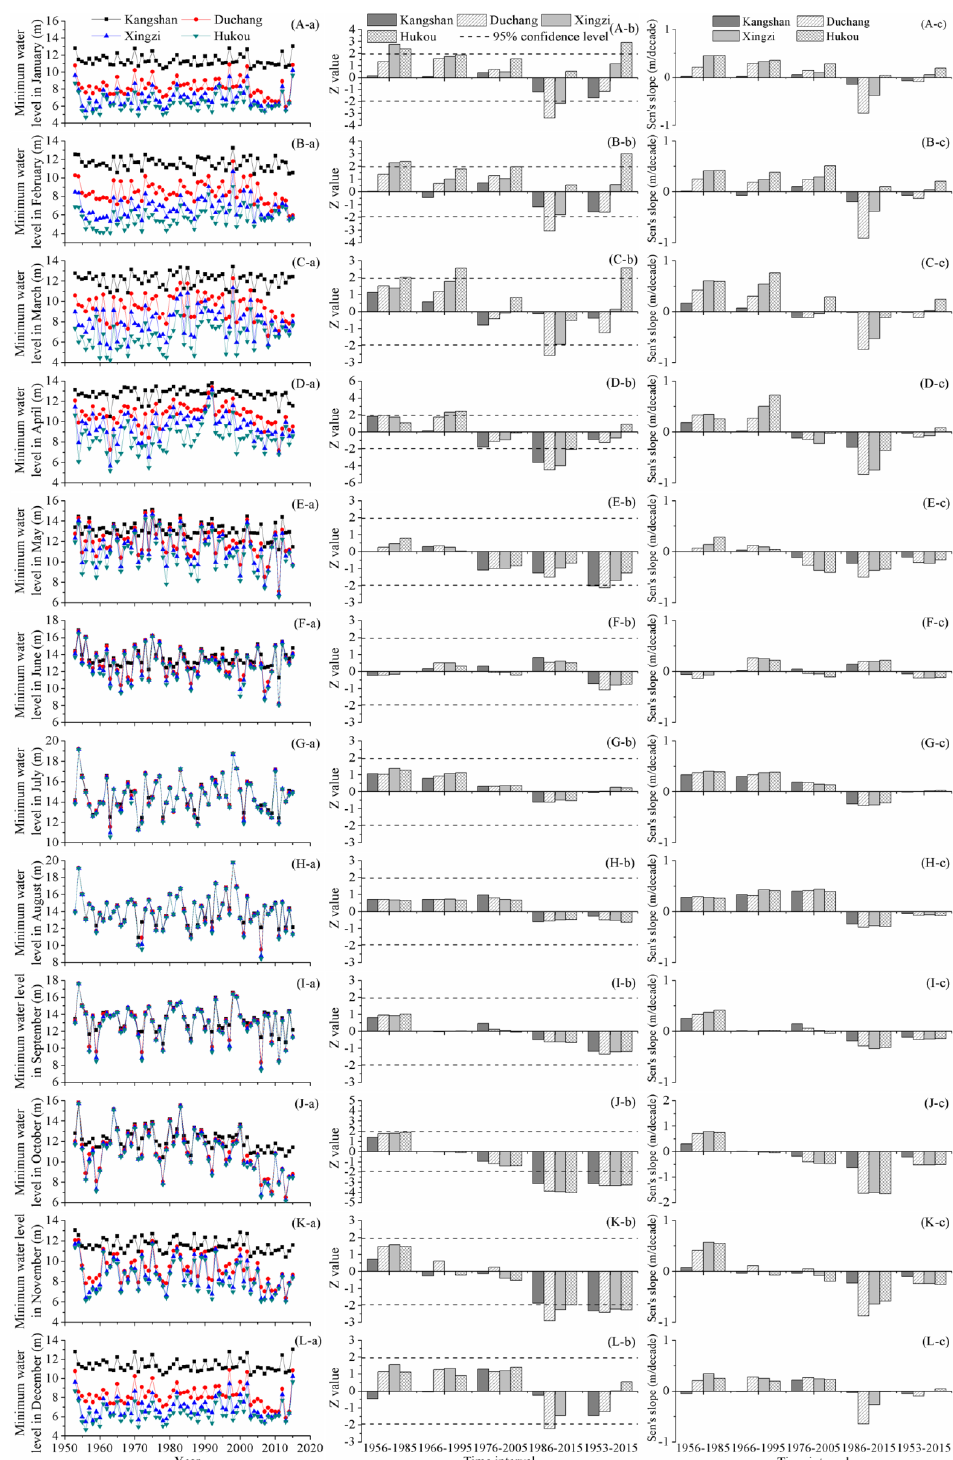
Figure 4. Variation features of monthly minimum water level in Poyang Lake: (i) the sub-figures from the top to the bottom rows that are labeled (A–L) display monthly minimum water level changes in January to December; and (ii) the sub-figures from the left to the right columns that are labeled (a–c) display annual values, Z values, and Sen’s slopes, respectively.